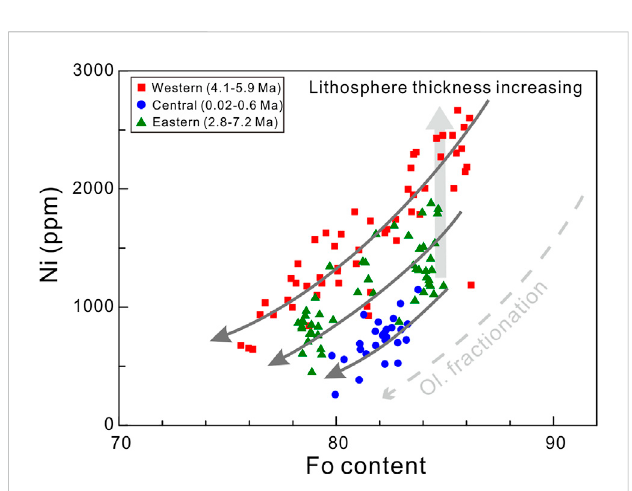
FIGURE 10 Cross-plotofNi(ppm)inolivineasafunctionofolivineFo.Thebold black arrows delineate the trends of element content for samples from the west, middle and